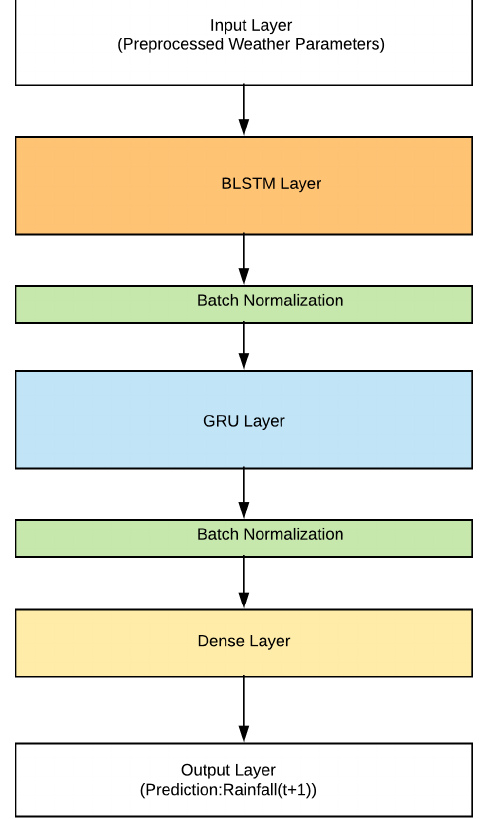
Figure 1. The proposed model is composed of 7 layers including the input and output layers. The embedding is generated by the Bidirectional Long Short Term Memory (BLSTM) and Gated Recurrent Unit (GRU) layer. The batch normalization is used for normalizing the data, and the dense layer performs the